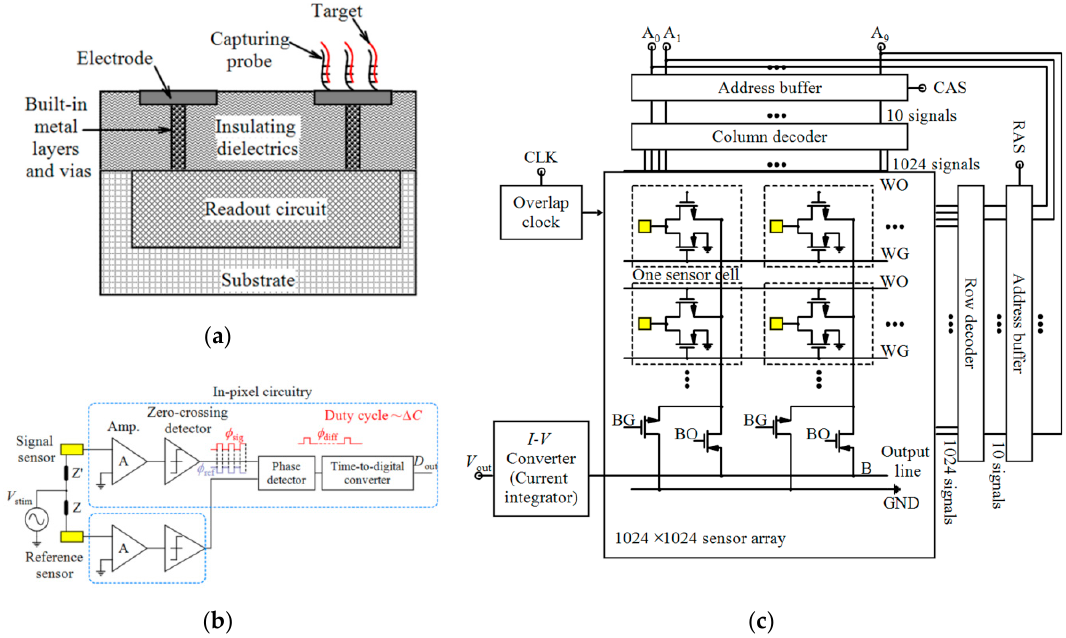
Figure 12. ( a ) General schematic of CMOS-based electrochemical sensors, ( b ) Architecture of in-pixel measurement in an electrochemical system by detecting the phase change between signal and reference electrodes , ( c ) Block diagram of an amperometric sensor.